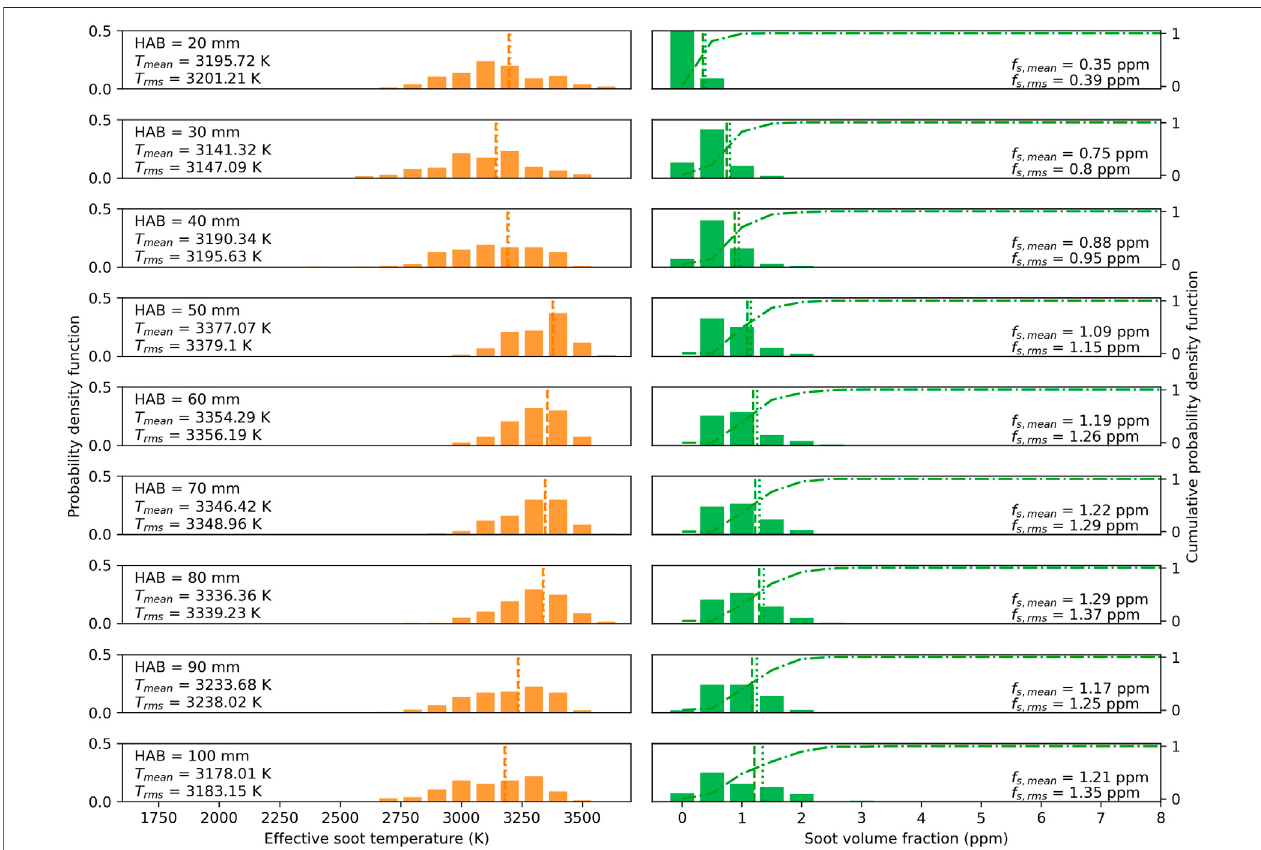
FIGURE 7| Probability density function (PDF, left axis) and cumulative PDF (right axis) of the instantaneous effectivesoottemperature and soot volume fraction at different HABs. The dashed and dotted vertical lines indicate the mean and RMS presented on Figure 6 ).